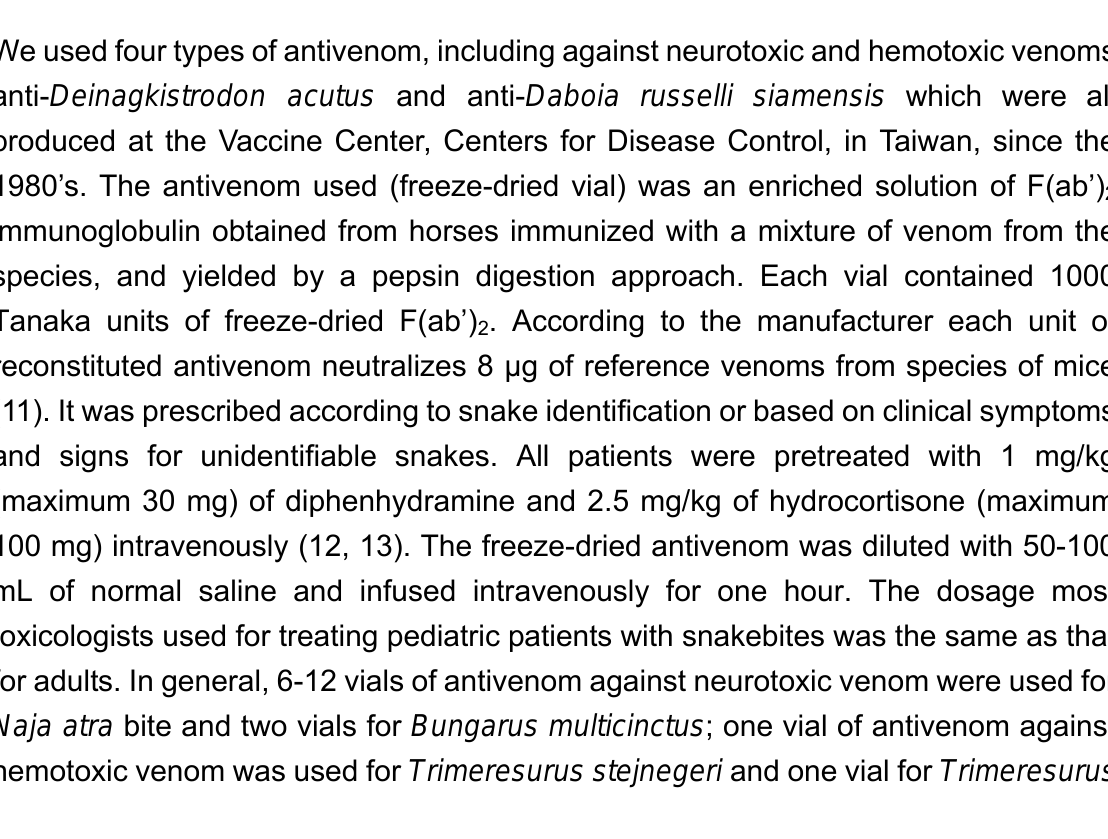
Figure 1. Flow chart of snakebite management in children from the Foundation for Poison Control of Taiwan (with